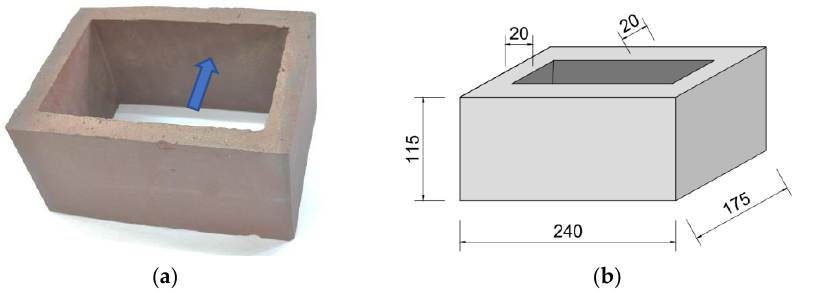
Figure 1. Hollow clinker unit: ( a ) view with visible slight bending of the outer rib (marked with an arrow); ( b ) nominal overall dimensions (in mm).